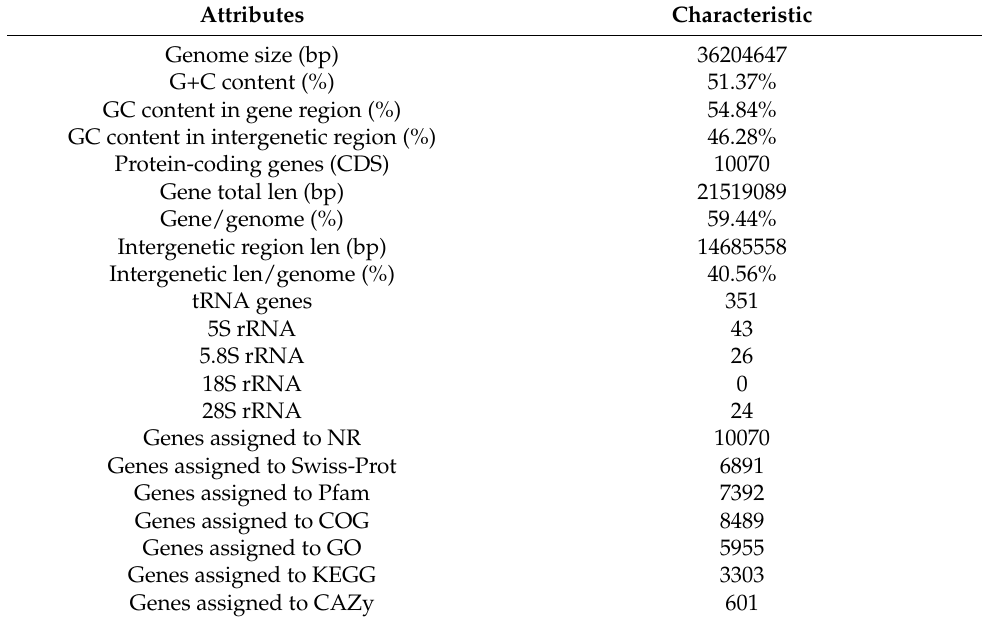
Table 5. The genome features of A. japonicas